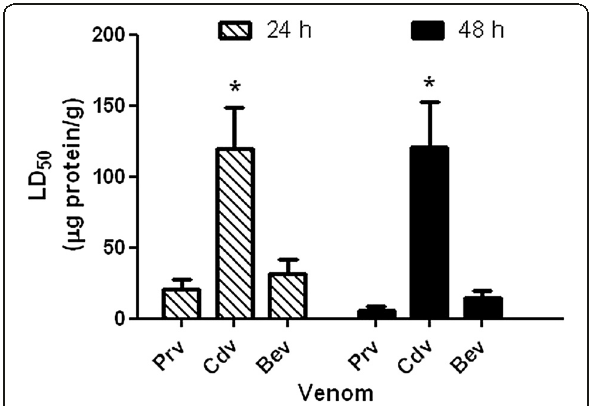
Fig. 1 Comparison of LD 50 values estimated from the injection of P. regalis ( Prv ), C. darlingi ( Cdv ), and B. epicureanum ( Bev ) venoms into crickets. Values represent the mean±standard error ( n =3). *Significant difference ( p